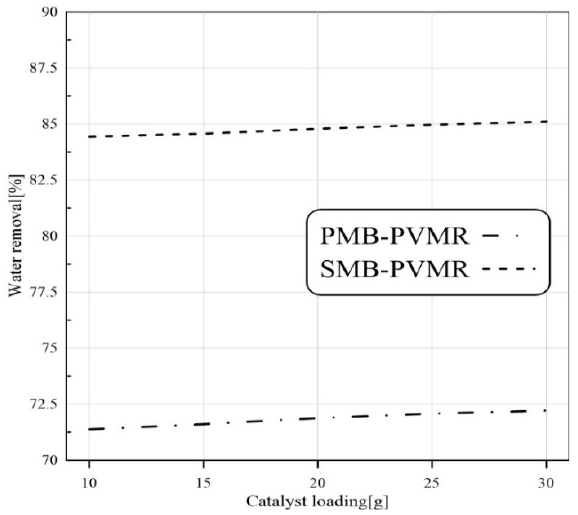
Figure 10. Comparison of water removal in MB-TR, PMB-PVMR, and SMB-PVMR based on the variations in catalyst loading. Et/LA: 1, temperature: 333 K, and feed flow rate: 10 mm 3 /s.